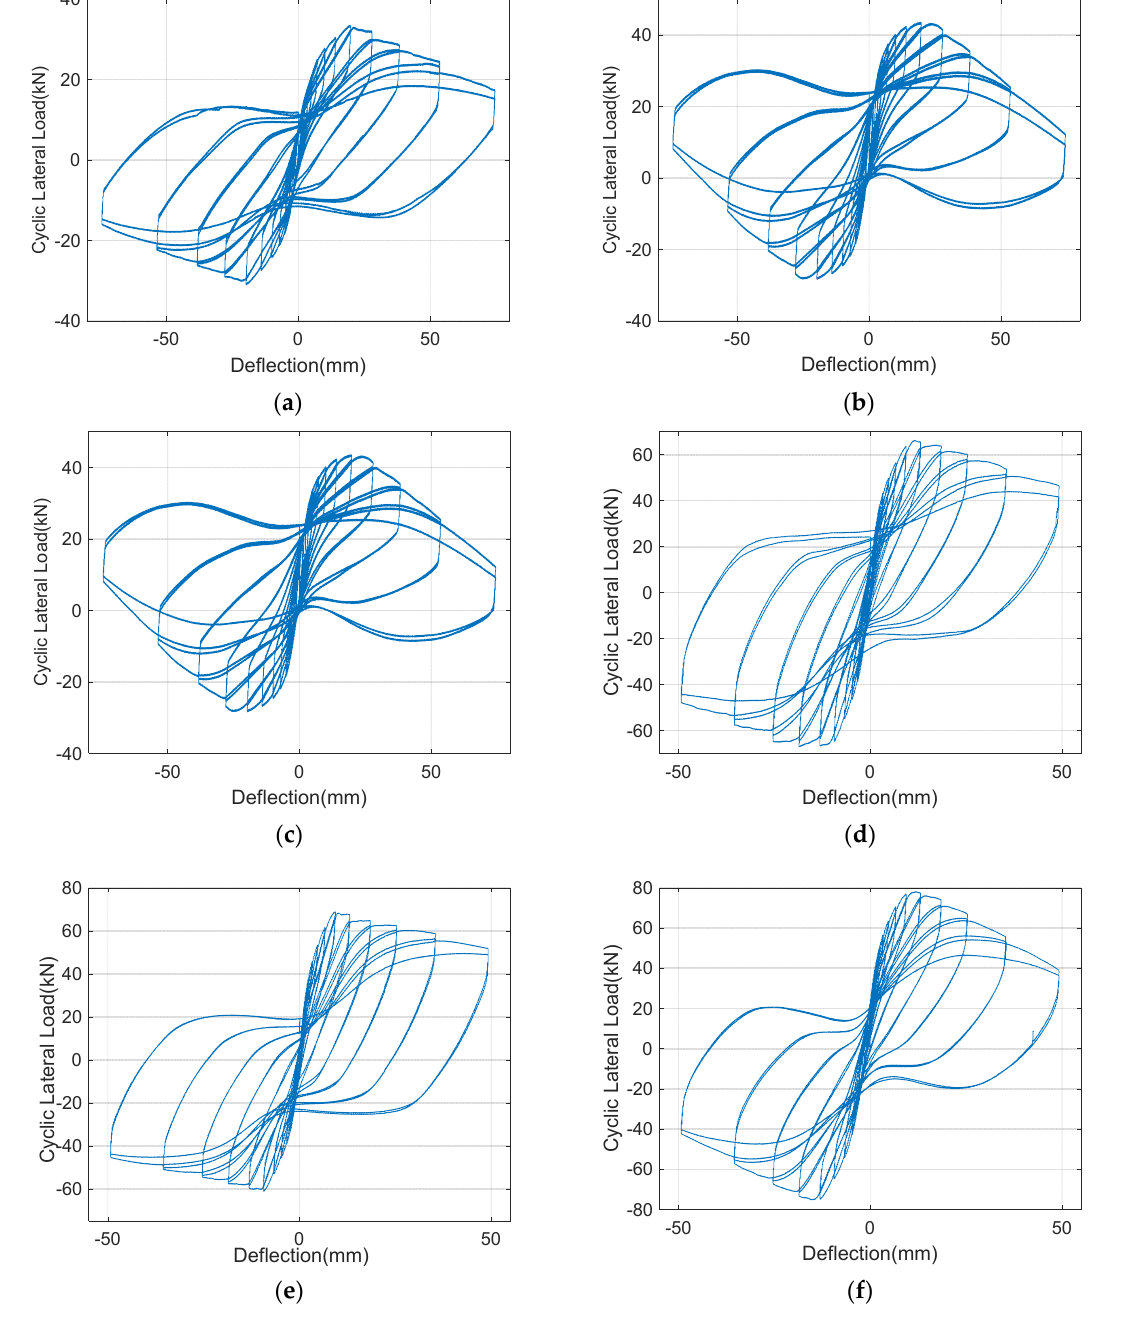
Figure 7. Load-displacement curves of ( a ) U-H-0.1, ( b ) R-H-0.1, ( c ) R-H-0.2, ( d ) U-S-0.1, ( e ) R-S-0.1, ( f ) R-S-0.2.